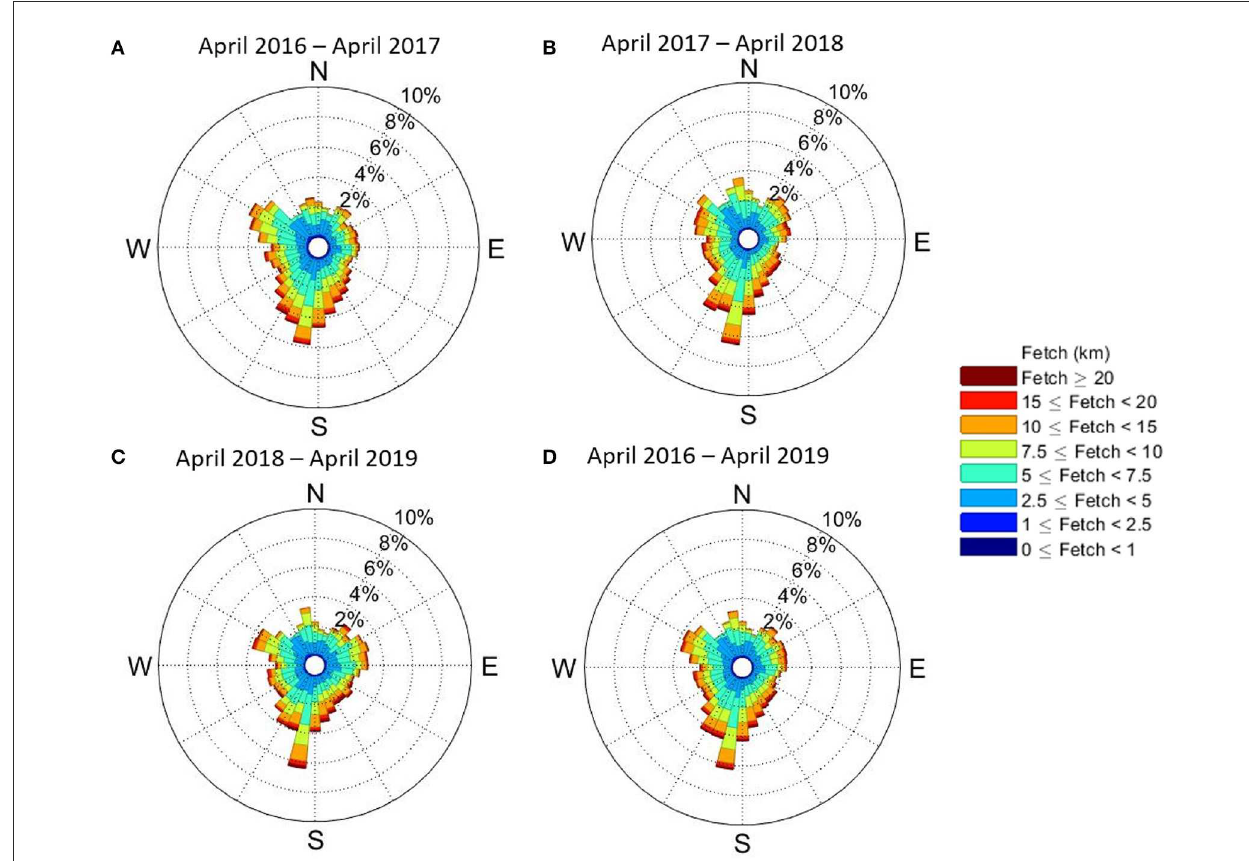
FIGURE6 Fetch rose plots show the relative frequency in length and location of the upwind distance (fetch) to the 90% of flux contribution for crop years (A) 2016 (i.e., April 2016 to March 2017), (B) 2017, (C) 2018, and (D) for April 2016 to March 2019. We keep a fixed 15% maximum frequency to compare the prevalent direction and frequencies across crop years. Using a polar coordinate gridding system, the fetch rose shows the frequency over a time period by wind direction with color bands showing fetch ranges. The direction of the longest spoke shows the direction of the upwind distance with the greatest frequency. The concentric circles are used to estimate the relative frequency of the fetch ranges. The fetch rose comprises 4 or more radiating spokes that represent cardinal wind directions, such as the 16-point compass fetch roses presented here. The fetch rose diagram is based on a wind-rose tool (Pereira, 2022) and the fetch for r 90 % of flux contribution (Kljun et al.,